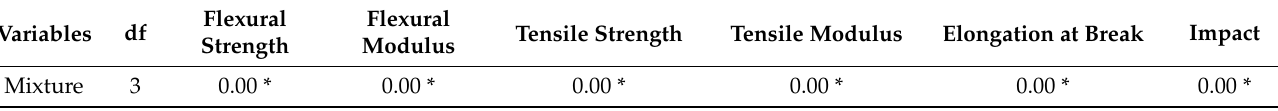
Figure 5. Impact strength of untreated and treated TPCS/PW/CCF composites at different NaOH concentrations. Letters a, b, and c is indicates the group of data for statistical analysis. Table 1. Analysis of variance (ANOVA) summary of TPCS/PW/CCF composites.